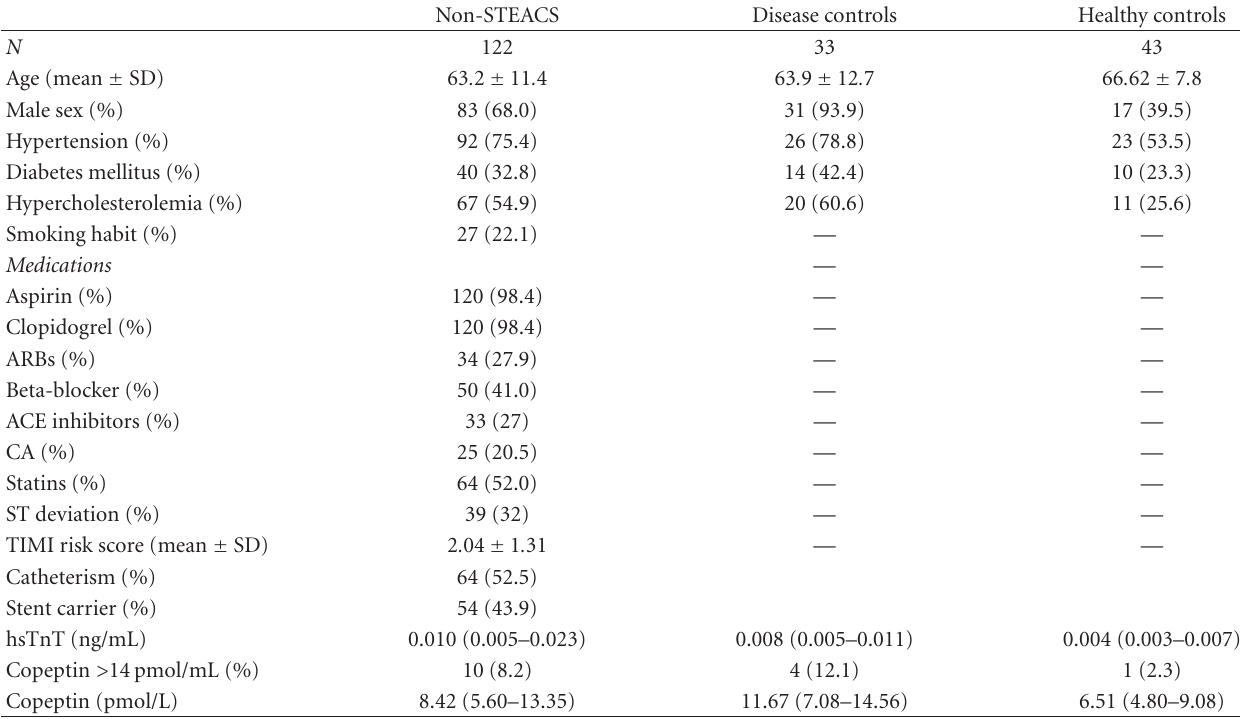
Table 1: Baseline characteristics of patients and controls.